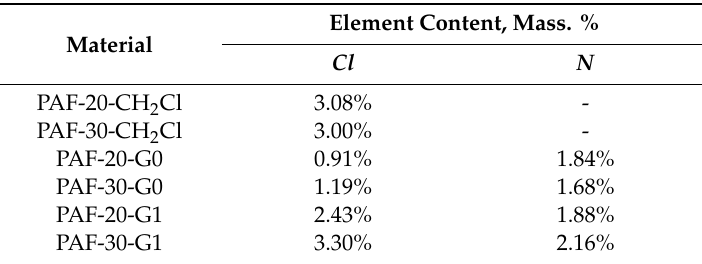
Table 2. Elemental analysis of synthesized materials.